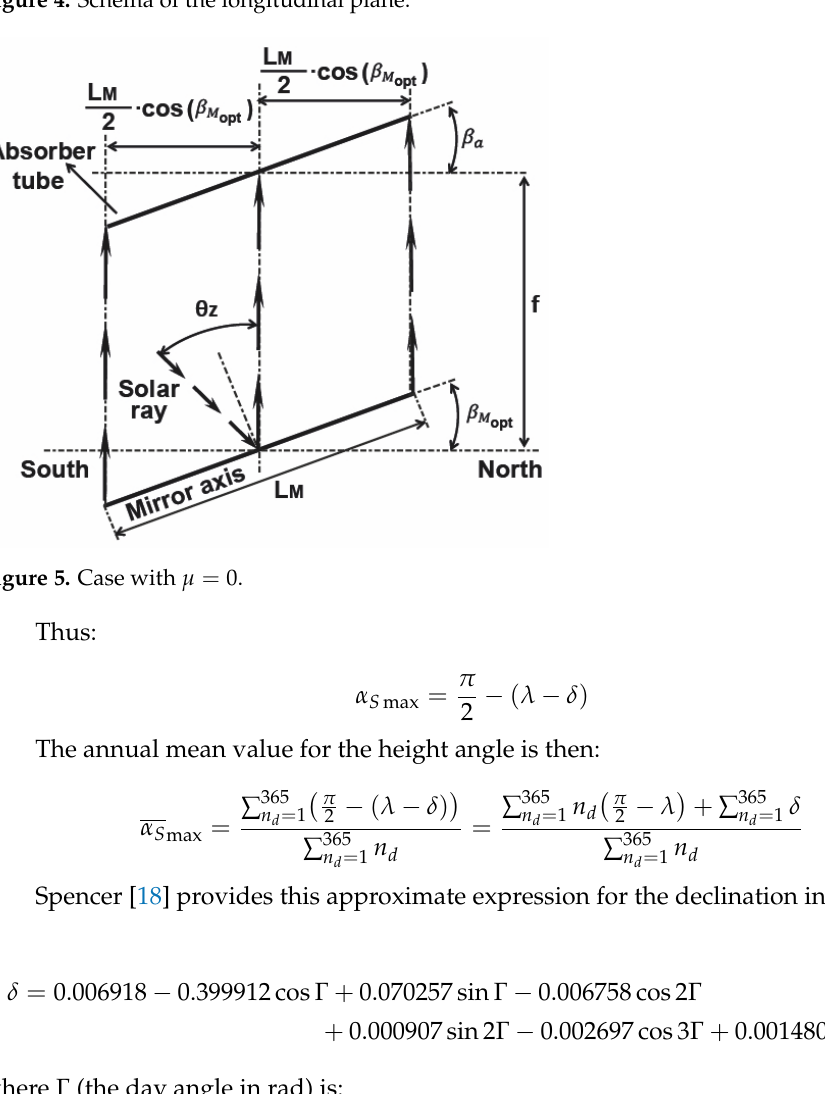
Figure 4. Schema of the longitudinal plane.